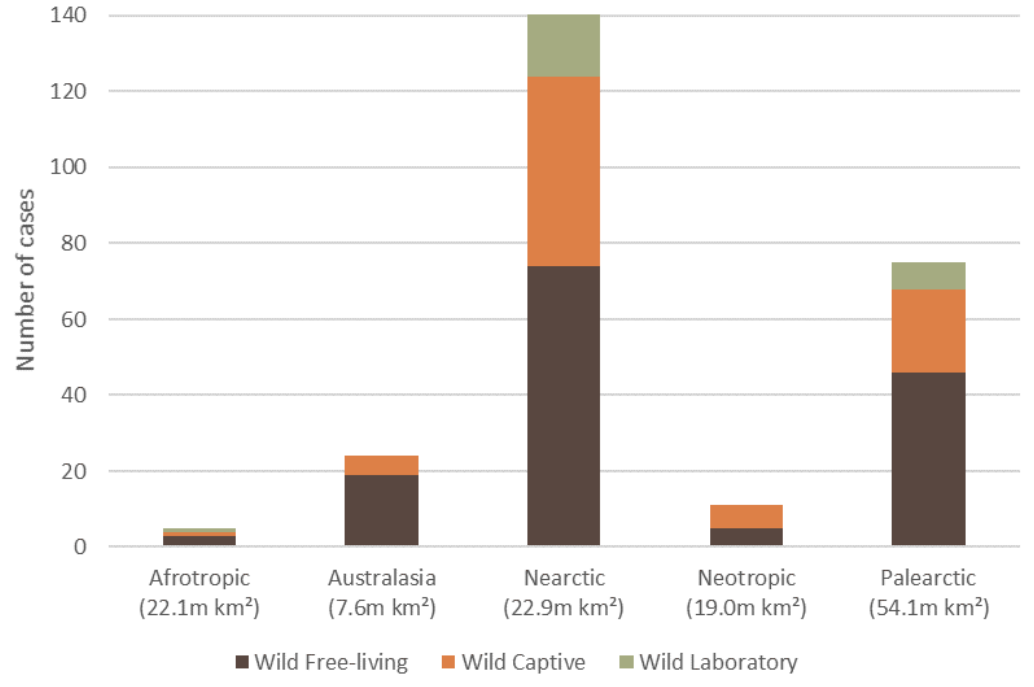
Figure 3. The total number of reported dermatitis cases split into captivity status (wild free-living, wild captive and wild laboratory), for five of the six biogeographical realms (ecozone) where mammalian wildlife dermatitis cases were reported in the literature, with an ecozone area (million km 2 ). There was one wild captive case recorded for the Indomalaya (7.5 m km 2 ) ecozone, which is not displayed.